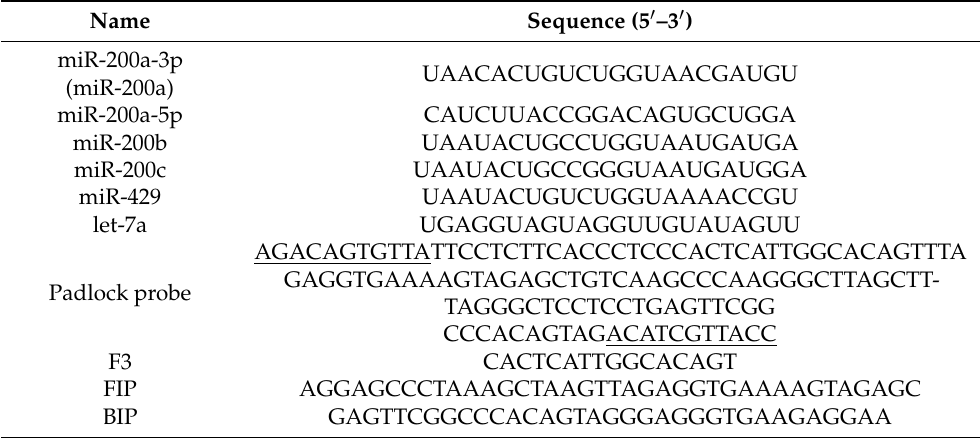
Table 1. miRNA and DNA sequences used in this